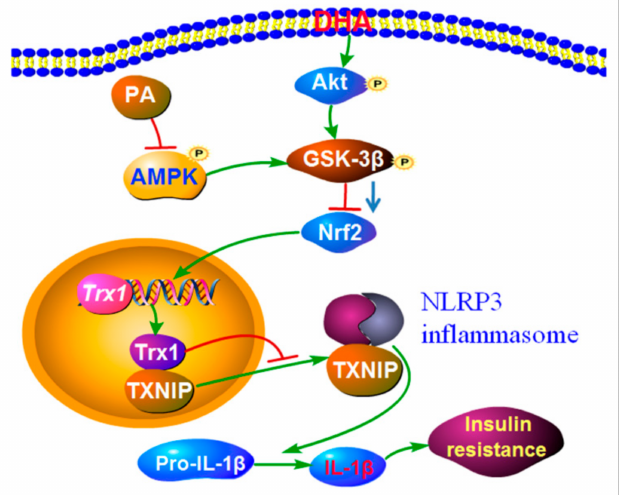
Figure 8. Schematic depicting the underlying mechanism by which endogenous n-3 PUFAs, especially DHA antagonize HF diet-induced insulin resistance. Mechanistically, PA, the main saturated fatty acid in HF diet inactivated AMPK and led to decreased GSK-3 β phosphorylation, at least partially through reducing Akt activity, which ultimately blocked the Nrf2/Trx1 antioxidant pathway and induced TXNIP cytoplasm translocation and NLRP3 inflammasome activation, whereas DHA, the most abundant n-3 PUFA in fat-1 adipose tissue, reversed this process via inducing Akt activation. Blue arrow indicates the inhibitory activity of GSK-3 β is weakened when GSK-3 β (Ser9) is